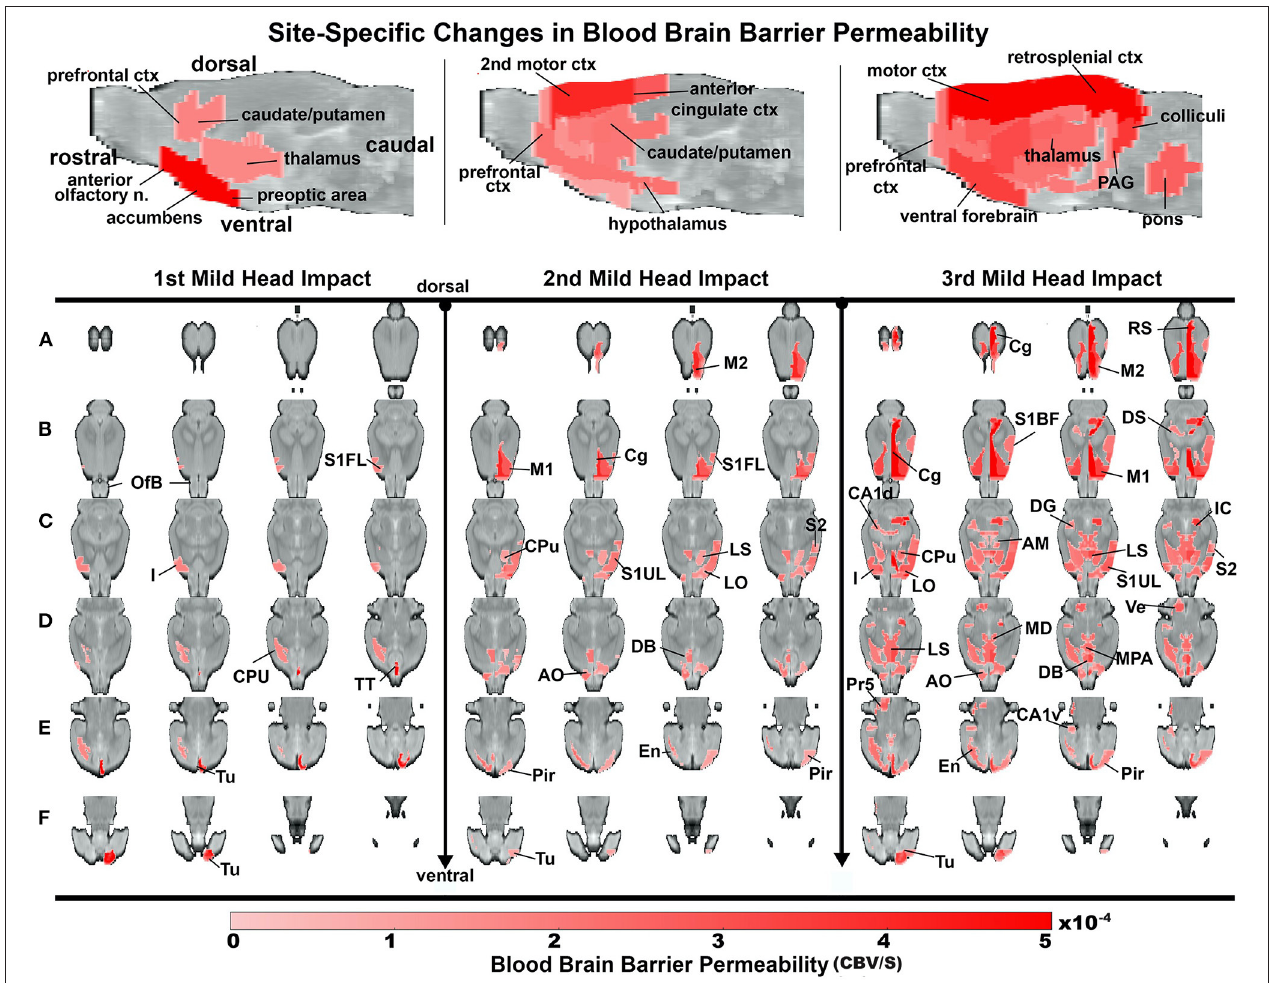
FIGURE 4 | Group site-specific changes in BBB permeability. A one-tailed repeated measures ANOVA with a Benjamin Hochberg correction ( p < 0.05; FDR = 0.1) was used to compare days of impact to the baseline. Coronal slices of the rat brain from dorsal to ventral depict regions of increased BBB permeability. Notably, the site of impact tested positive after the 2nd and 3rd impact. The color scale value is the difference in slope from baseline and is only displayed if the region is statistically significant.